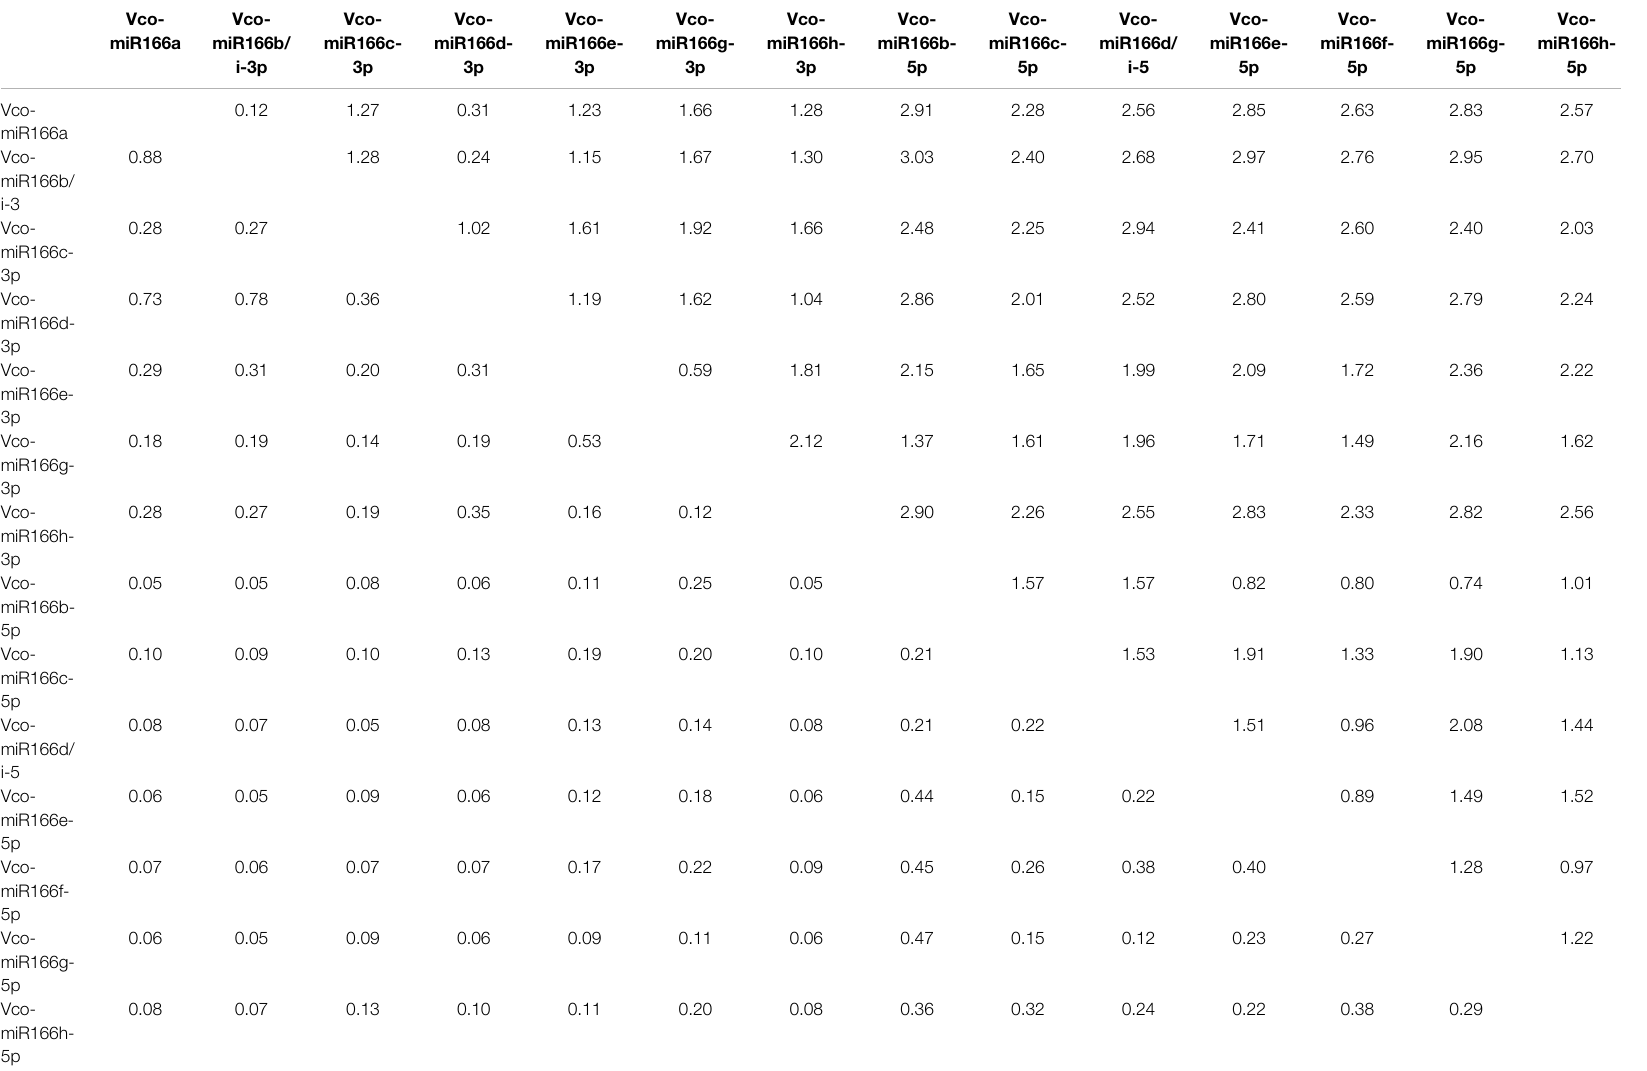
Genetic distances are indicated in the upper right triangle; genetic similarity is shown in the lower left